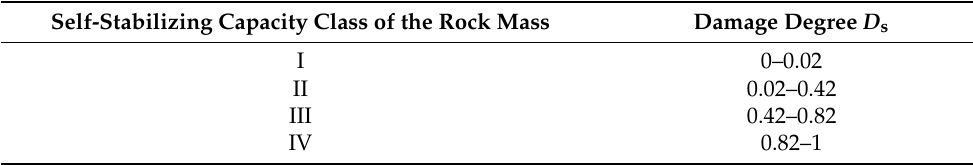
Table 7. Classification of the self-stabilizing capacity of the rock mass.